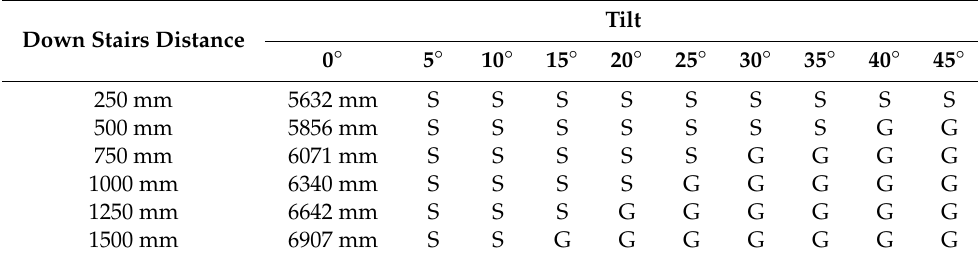
Figure 5. Top (up) and lateral (down) view of the different scans obtained when having stairs going down at a fixed distance of 1250 mm depending on the 2D LIDAR tilt angle. The tilt of the LIDAR has been changed from 0° (horizontal) to 45° in increments of 5°. The distance points originated by the surrounding walls difficult the visual interpretation of the data shown. Table 4. Stairs going down detection results obtained for different distances and LIDAR tilt angles: (S) hole or stair going down detected, (G) ground detected at the expected location, (numeric value) average distance of a frontal obstacle.